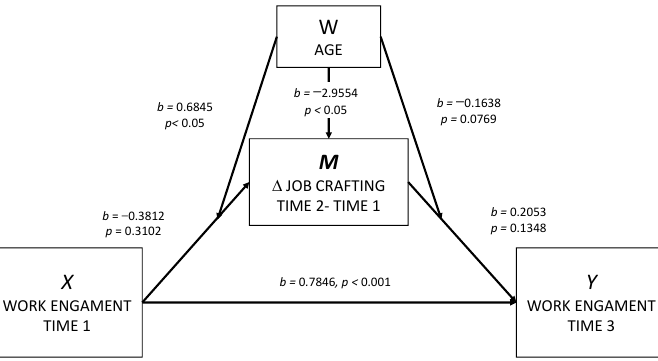
Figure 2. Main findings for this study applying the Model nº 58 from Hayes.